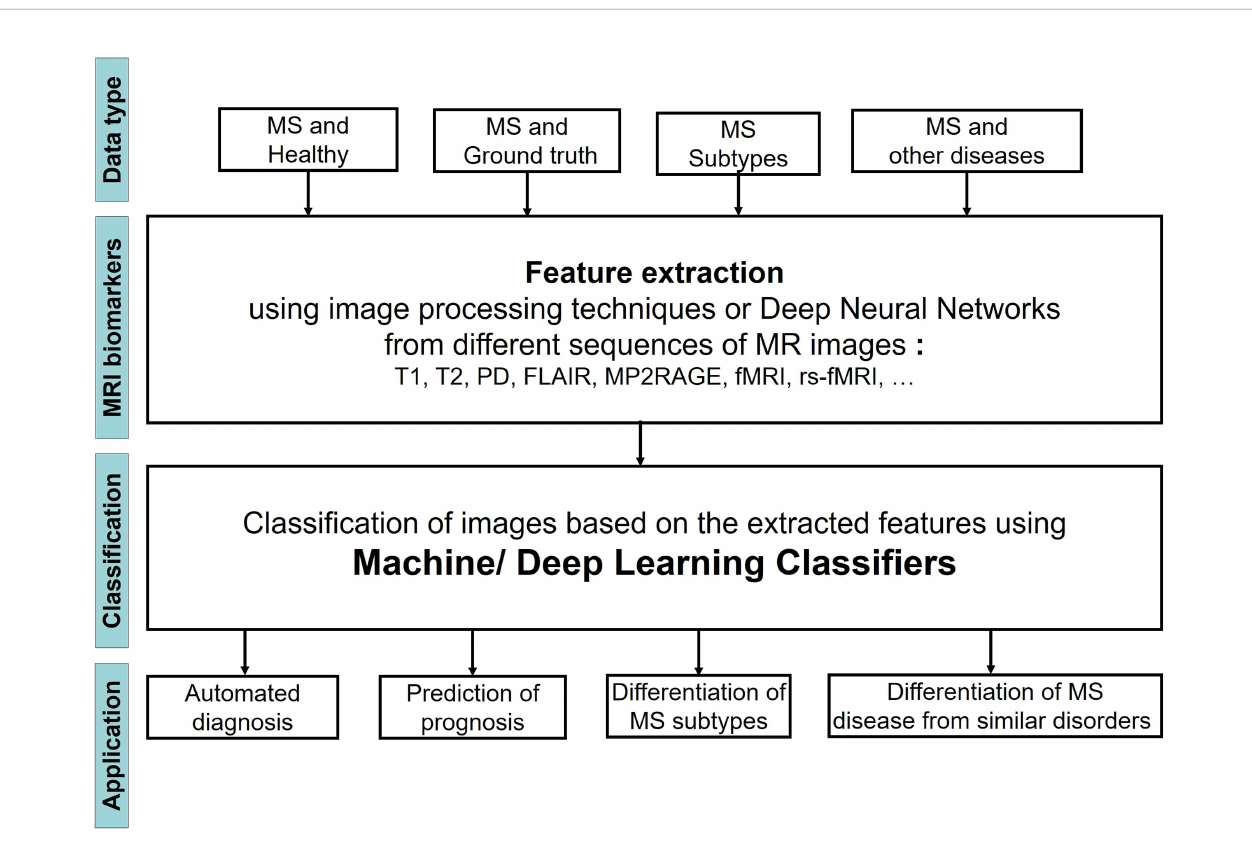
FIGURE 1 | Flowchart showing the process of using ML Learning to study MS through MRI